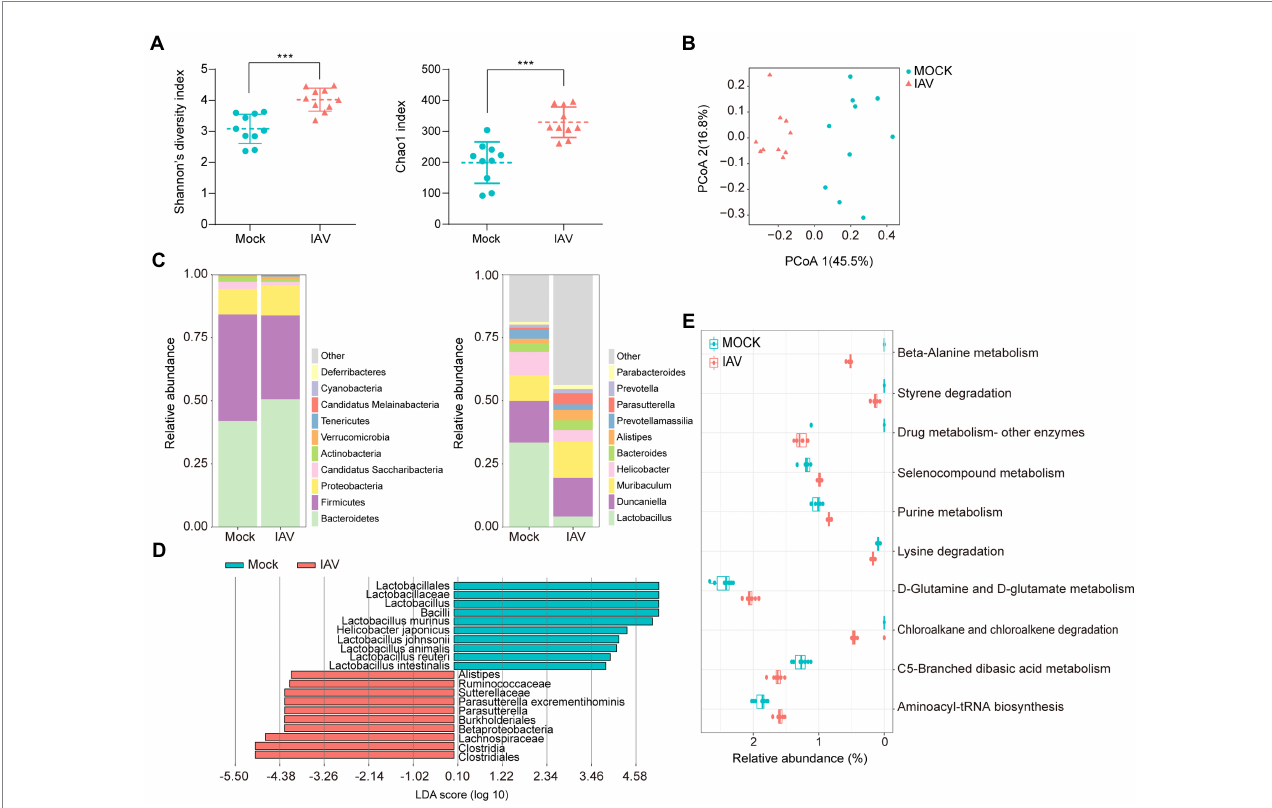
FIGURE 5 Characterization of gut microbiota and correlation between gut and oropharyngeal microbiota during IAV infection. (A) Shannon diversity and Chao1 indices of gut microbiota in IAV and mock groups. (B) 2D-PCoA plots of gut microbiota in mock and IAV groups (C) Relative abundance of the top 10 bacteria at the phylum and genus levels of gut microbiota in mock and IAV groups. (D) LEfSe analysis at the species level of gut microbiota in mock and IAV groups. (E) Top 10 significantly altered metabolic pathways of gut microbiota between mock and IAV groups. Pathway abundance prediction by PICRUSt2. Statistical analyses of Shannon index, Chao1 index and bacterial taxa abundance were conducted by using the Mann–Whitney test. * p < 0.05, ** p < 0.01, *** p <